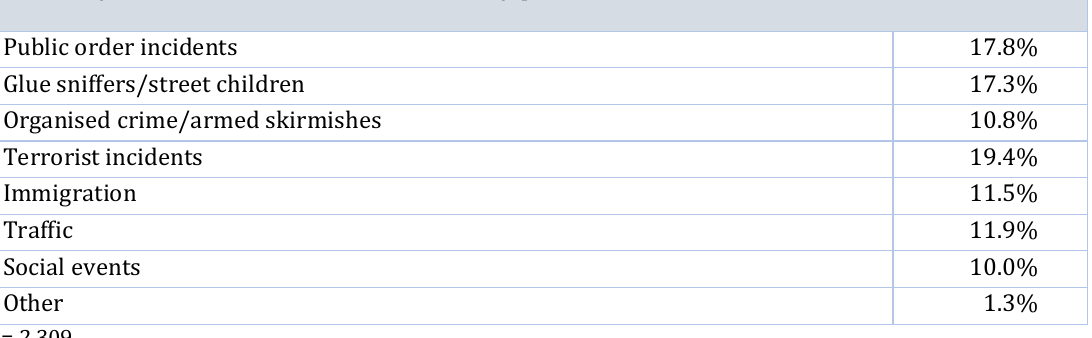
Table 3: The most serious security problem in Istanbul What do you think is the most serious security problem in Istanbul?